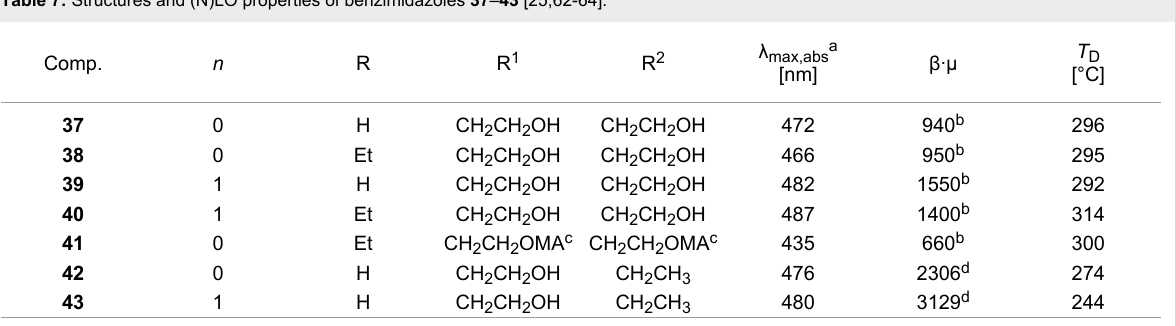
Table 7: Structures and (N)LO properties of benzimidazoles 37 – 43 [25,62-64].